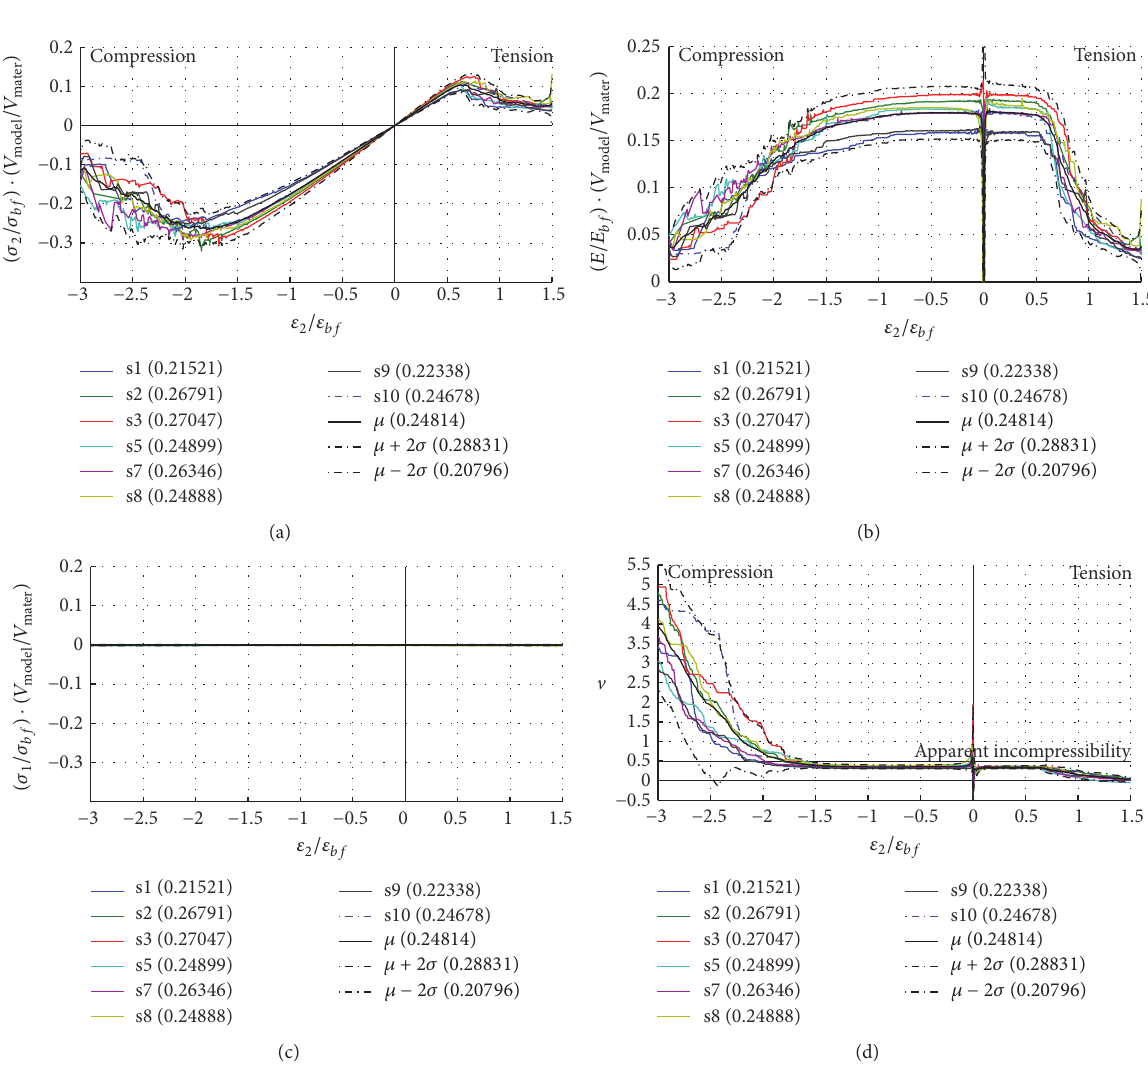
Figure 3: Individual response curves of unreinforced discrete specimens ( 15 × 15 MHD) to uniaxial plane-stress loading, along with sample mean response curves (solid black line) and 2 𝜎 -envelopes (dashed dotted black line). Stresses and moduli of elasticity are made comparable across samples by division with the observed volume density 𝑉 mater / 𝑉 model of each specimen (given in parenthesis in the legend). (a) Stress in direction of loading. (b) Secant modulus of elasticity. (c) Stress across loading (zero throughout). (d) Secant Poisson ratio (apparent incompressibility observed at limit point in